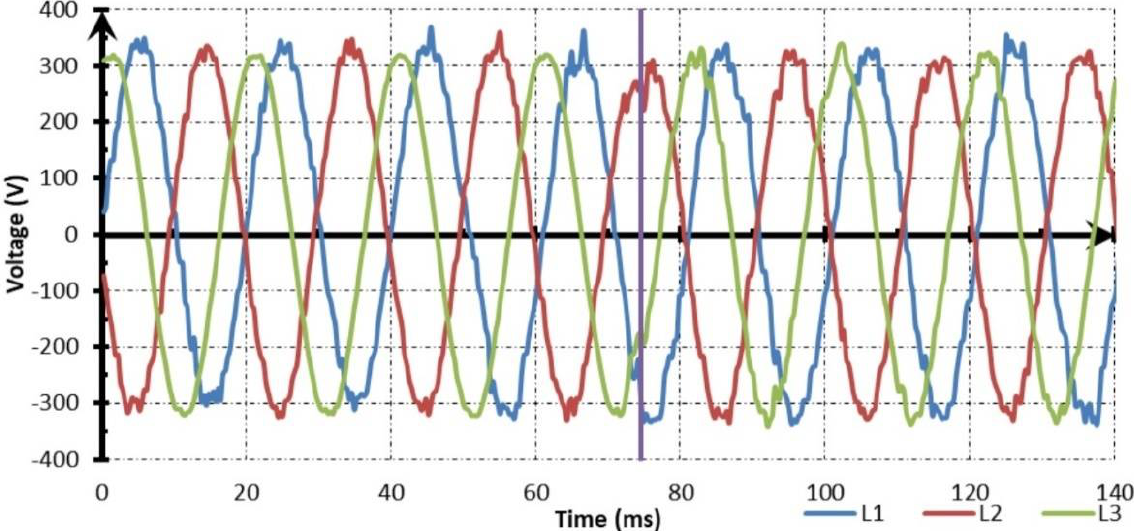
Figure 8. Voltage waveforms during the transition from network to islanding mode operation.